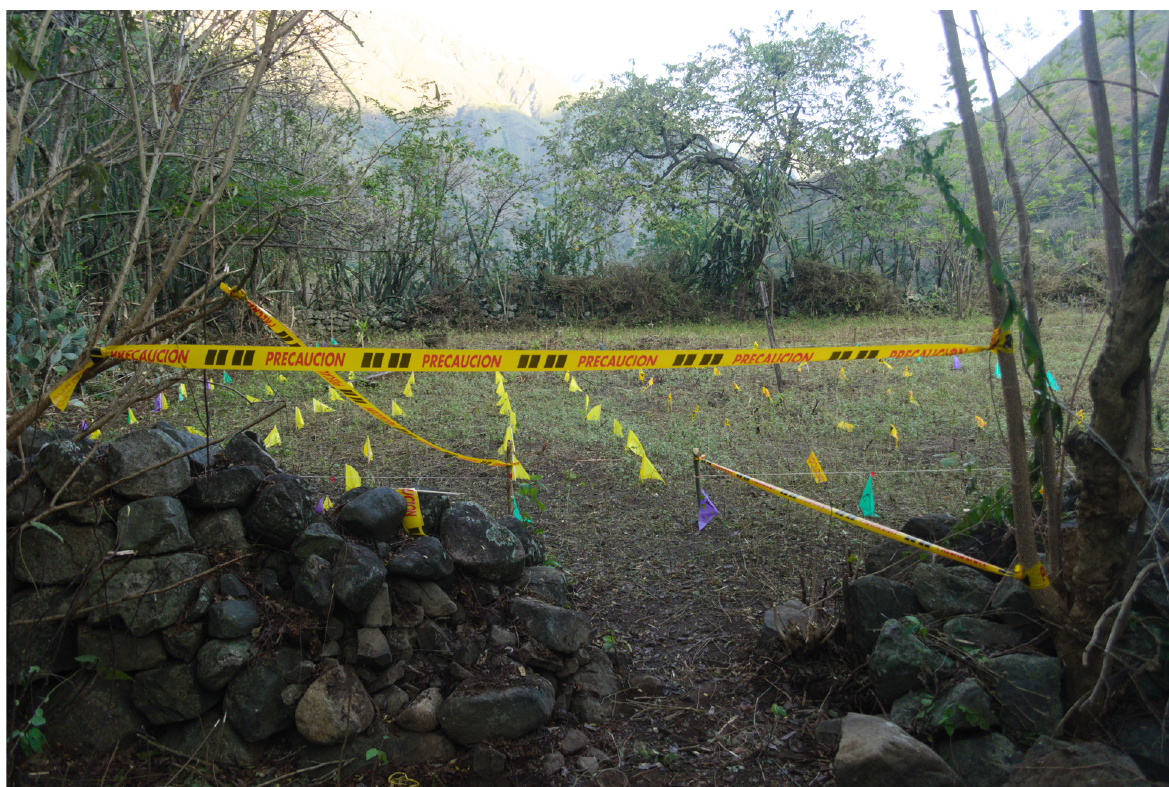
Figure 2. Photographs of the Barbacoas Cemetery with Flags Indicating Field Assessment Methods. Source: Image from the project, Field Assessment